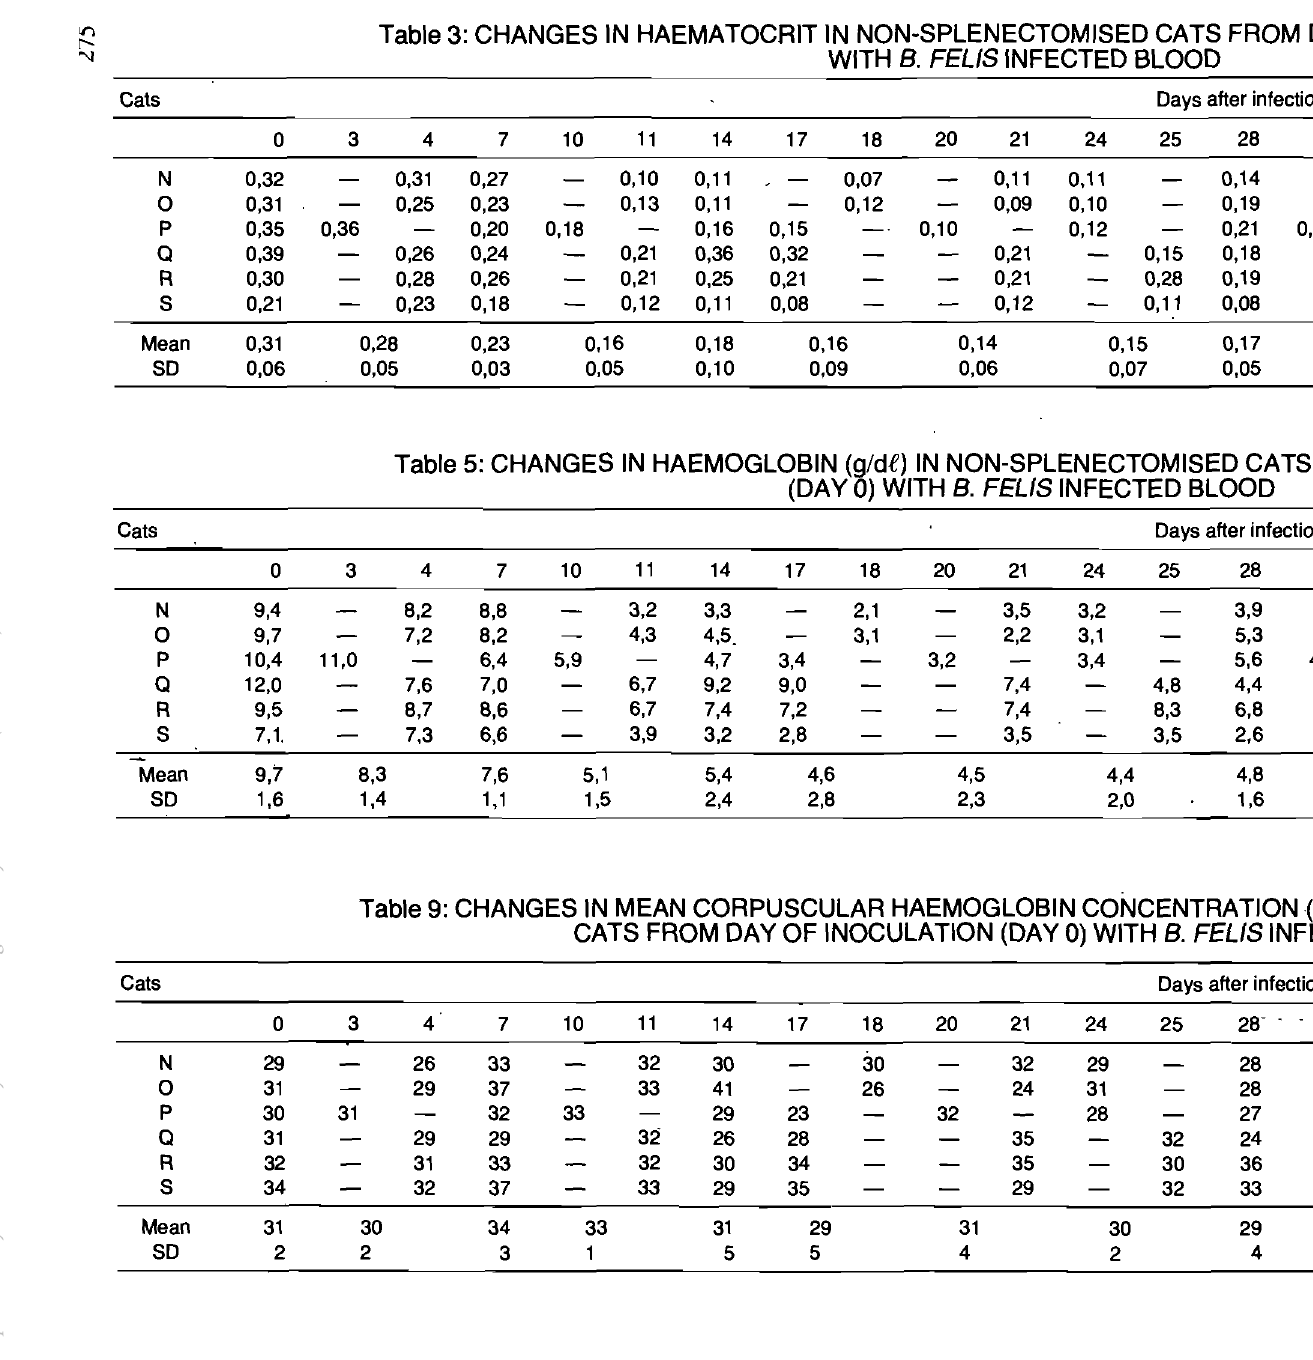
~ u.. 0 ...J ~ CATS FROM DAY OF INOCULATION (DAY 0) WITH B_ FELIS INF CTED BLOOD ~ 0